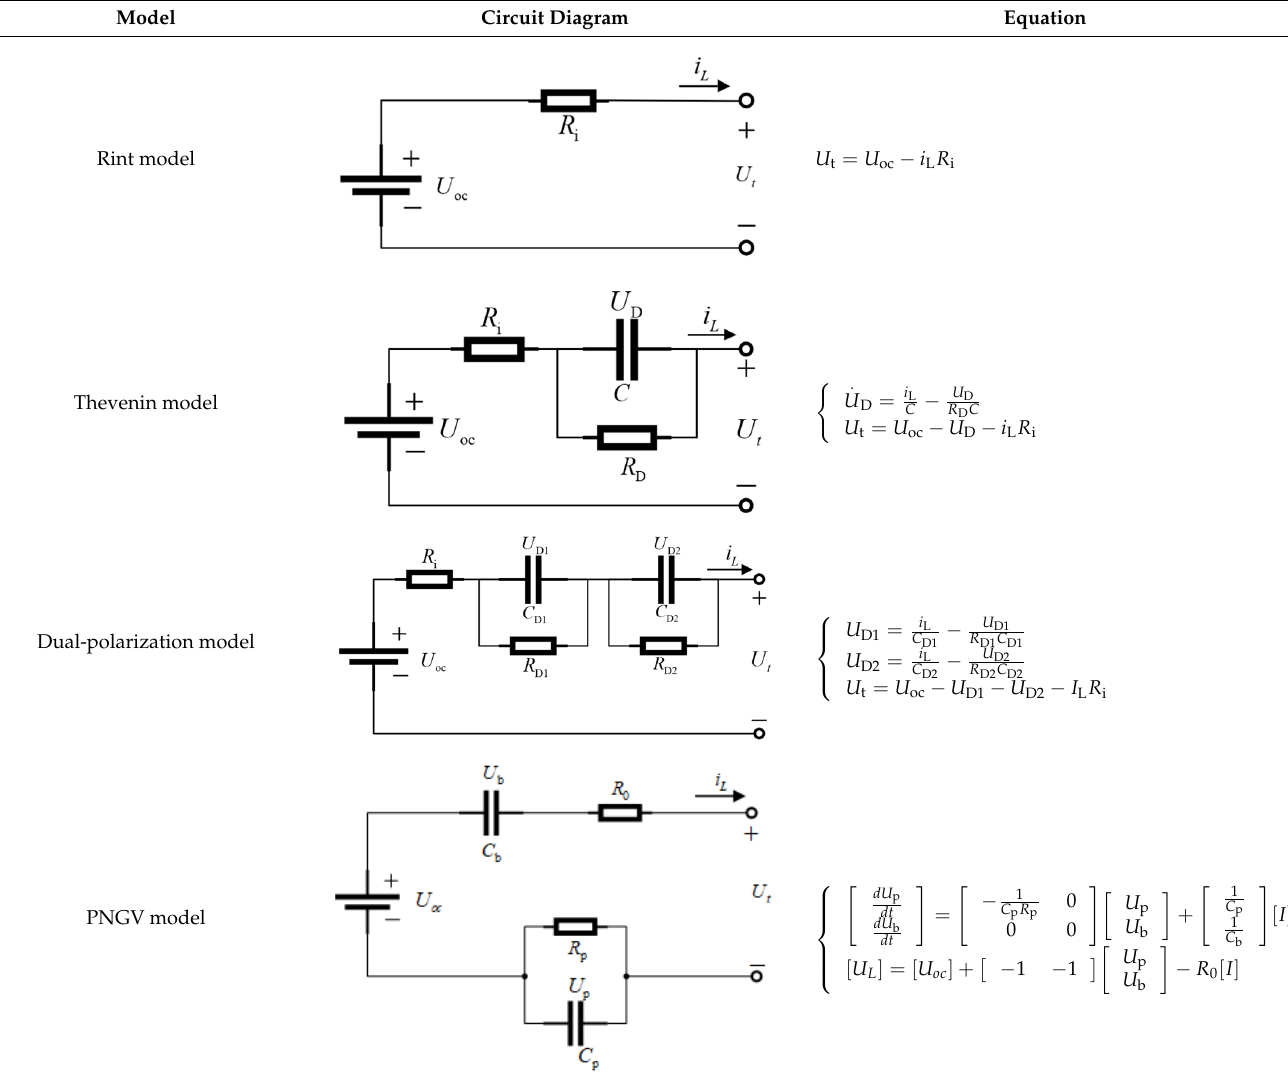
Figure 2. Flow chart of genetic algorithm. (The cyclic process of optimizing parameters is reflected in the red dotted box in the figure).